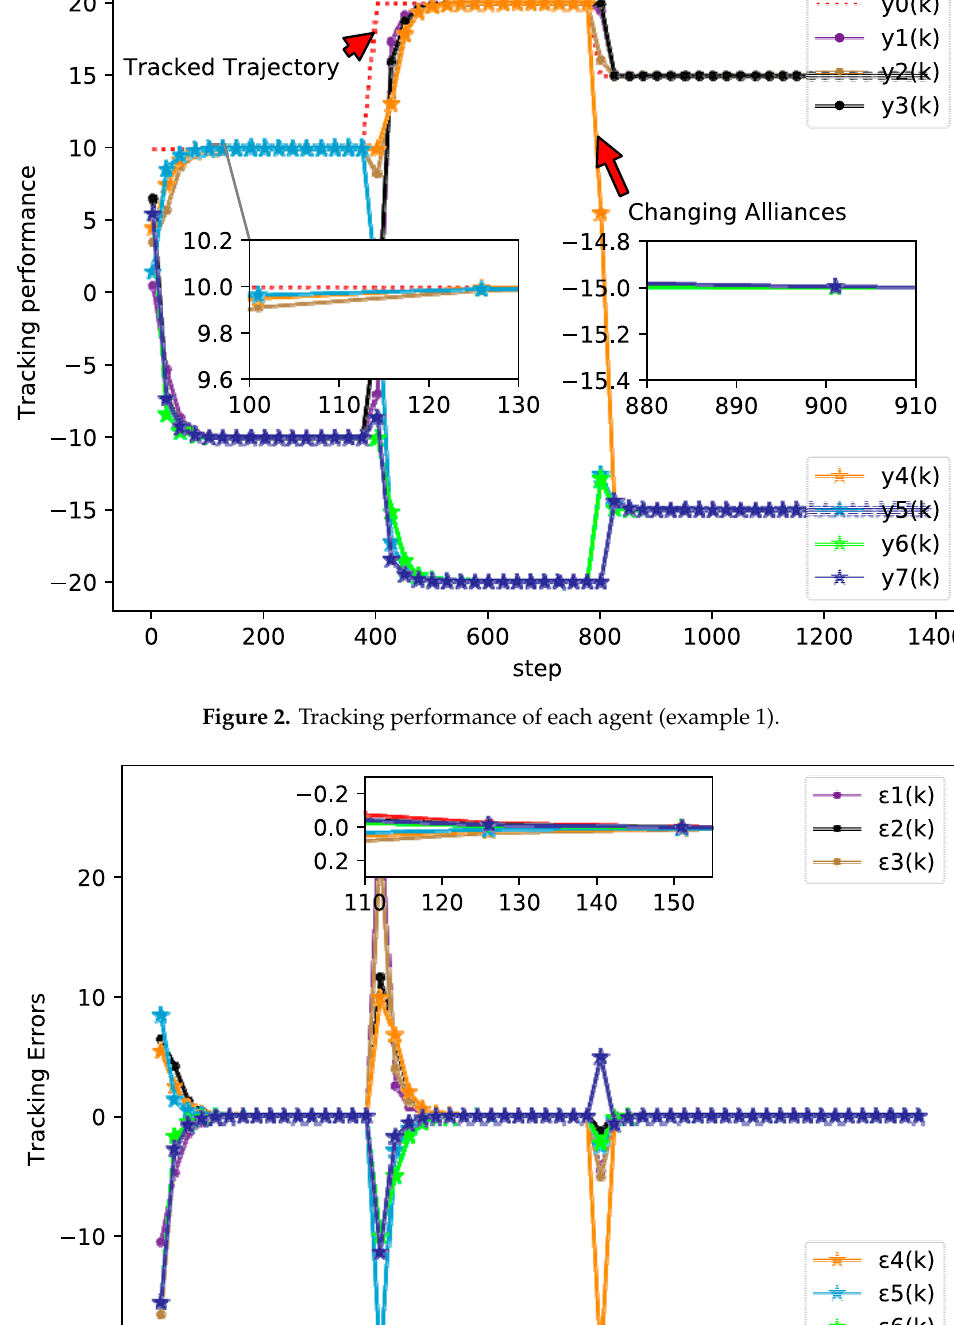
Figure 4. Pseudo partial derivative (PPD) estimation of each agent (example 1).